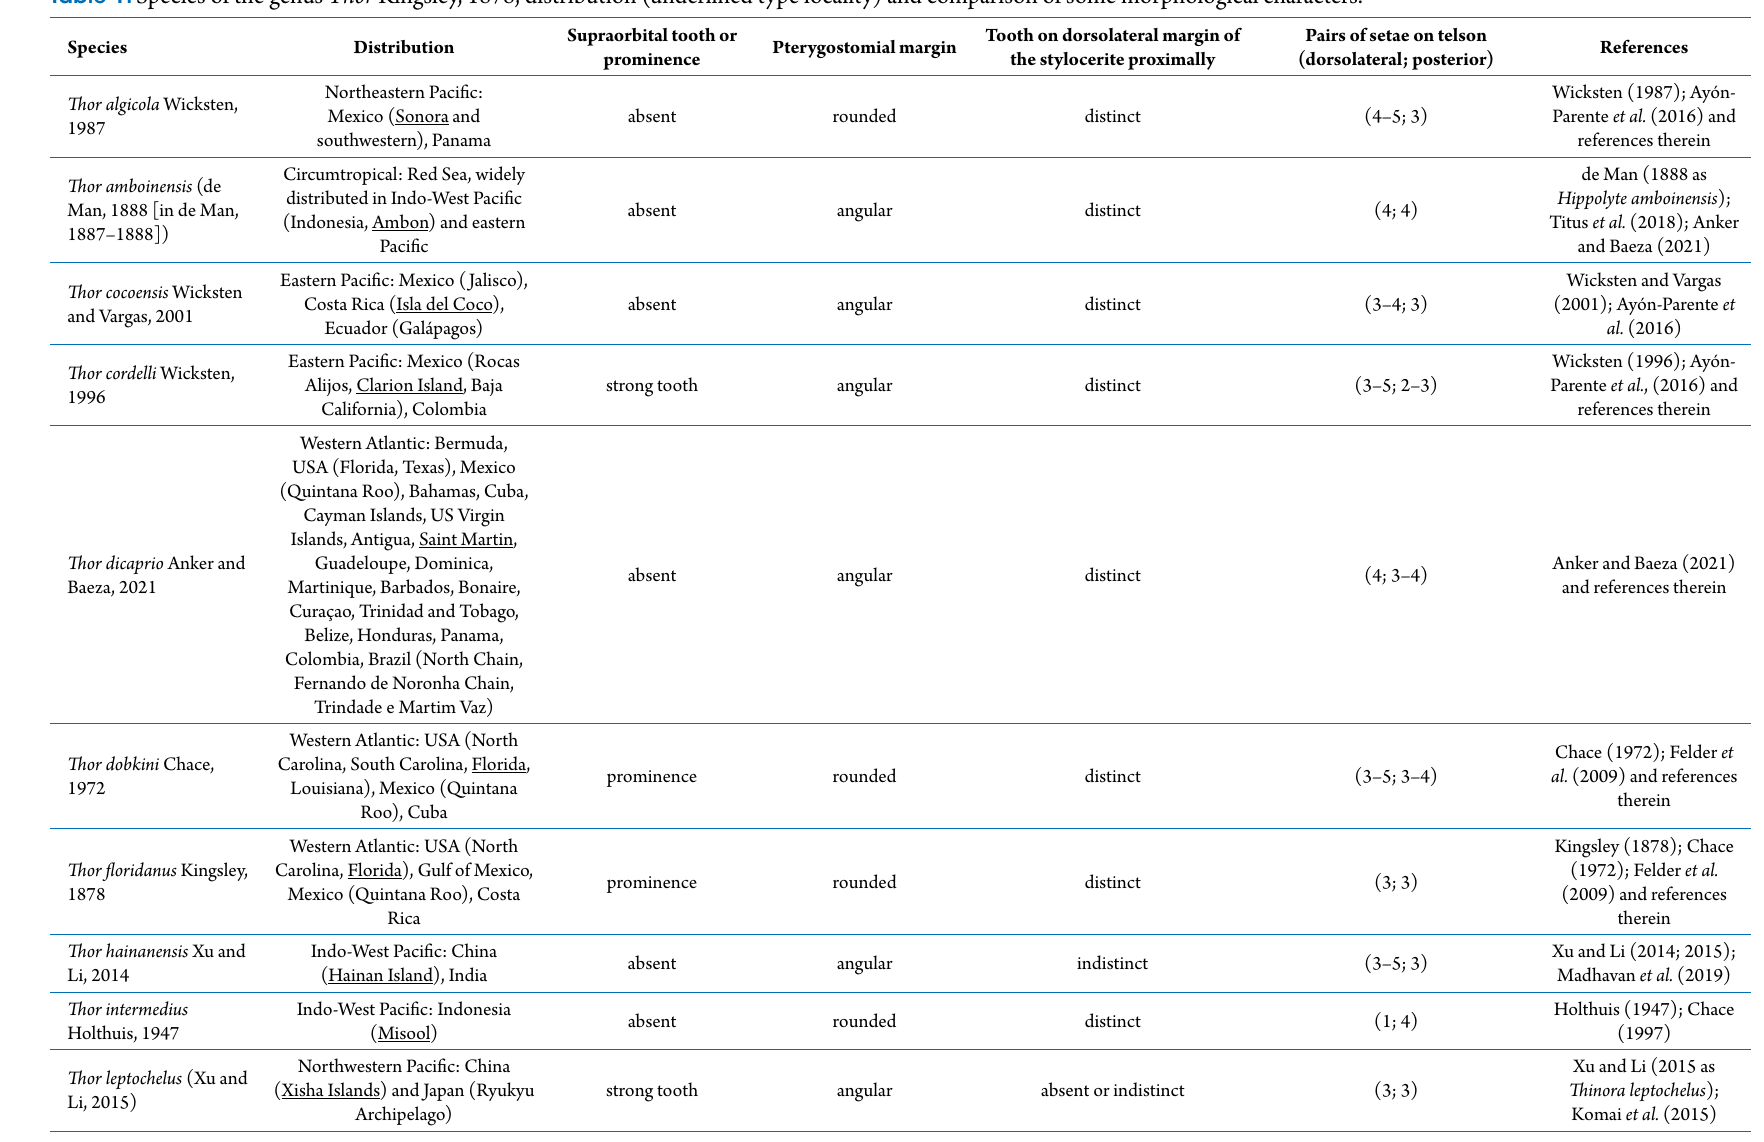
Table 1. Species of the genus Thor Kingsley, 1878, distribution (underlined type locality) and comparison of some morphological characters.